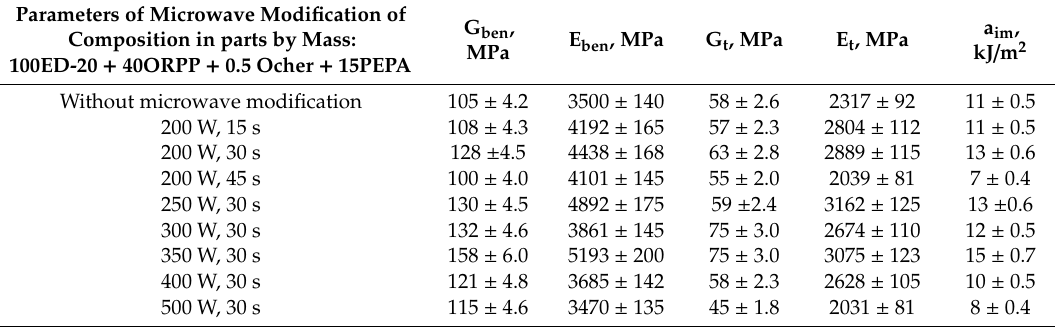
Table 5. Properties of epoxy